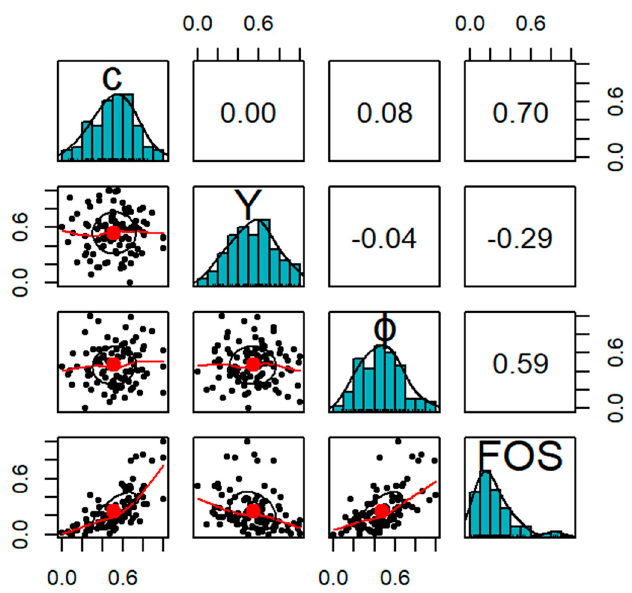
Figure 3. Correlation plot among input variables (c, Υ , ϕ ) and response variable (FOS).